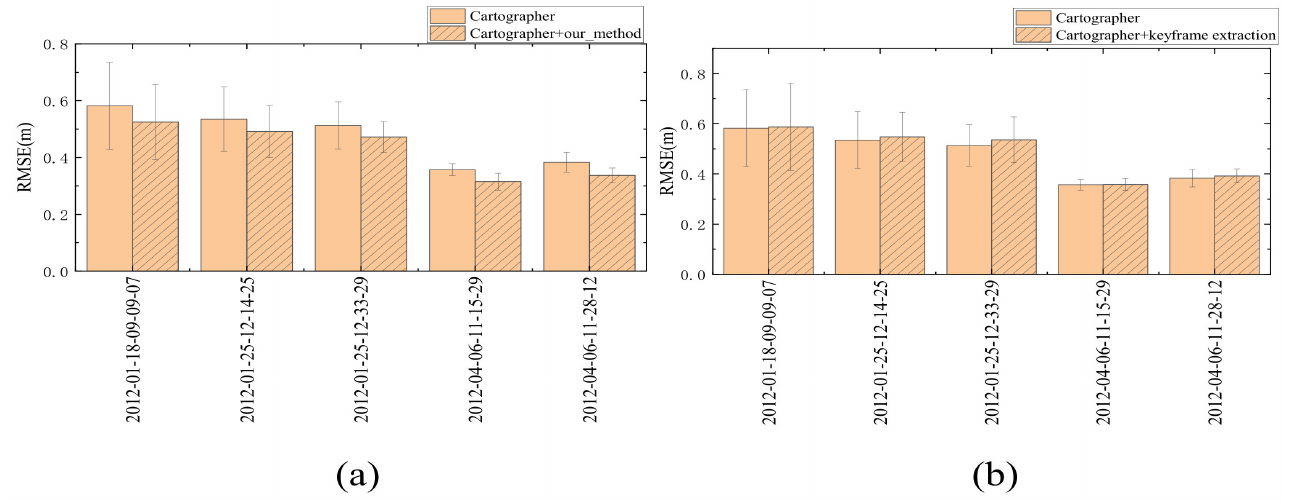
Figure 11. Columnar error diagram of two usage modes. ( a , b ) represent the influence of different methods on the trajectory accuracy. Figure ( a ) shows that our method can improve the trajectory accuracy to a certain extent. Figure ( b ) shows that the keyframe extraction method does not reduce the trajectory accuracy.